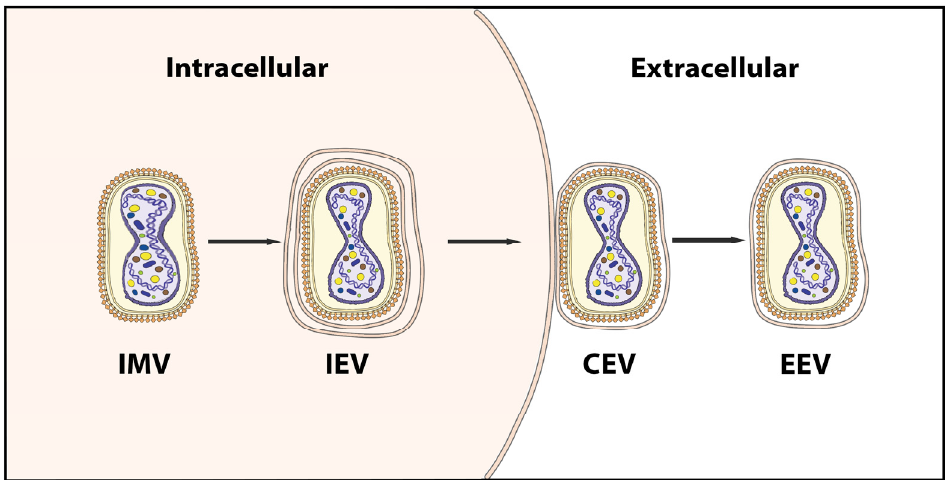
Figure 1. Schematic of the four infectious virion forms of poxviruses produced during the virus life cycle. IMV, intracellular mature virus; IEV, intracellular enveloped virus; CEV, cell-associated enveloped virus; EEV, extracellular enveloped virus.